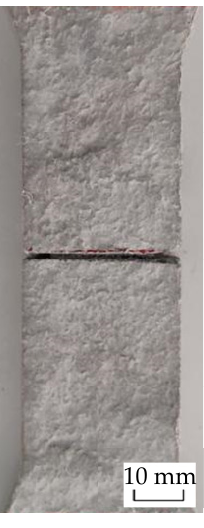
Figure 15. Failure mode of the single-seam tensile specimen.